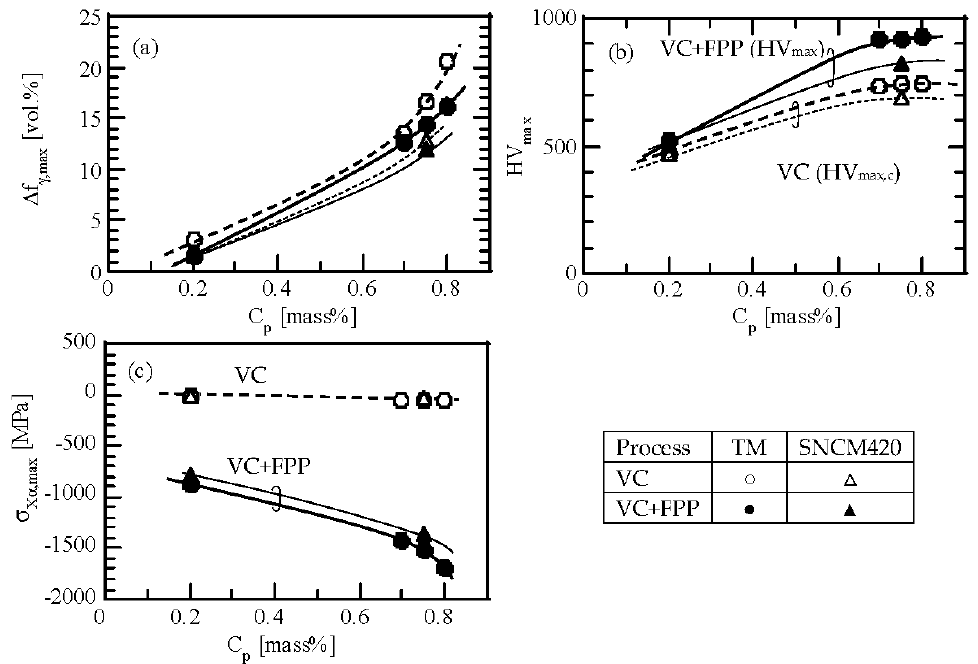
Figure 4. Variations in ( a ) maximum volume fraction of the retained austenite ( f γ ,max ), ( b ) maximum hardness (HV max ), and ( c ) maximum compressive residual stress ( σ X α ,max ) as a function of carbon potential ( C P ) in TM ( ○ ● , thick lines) and SNCM420 ( △▲ , thin lines) steels after vacuum ‐ carburization (VC) or after vacuum carburization and subsequent fine ‐ particle peening (VC + FPP). HV max,c is HV max of as ‐ vacuum ‐ carburized steels.